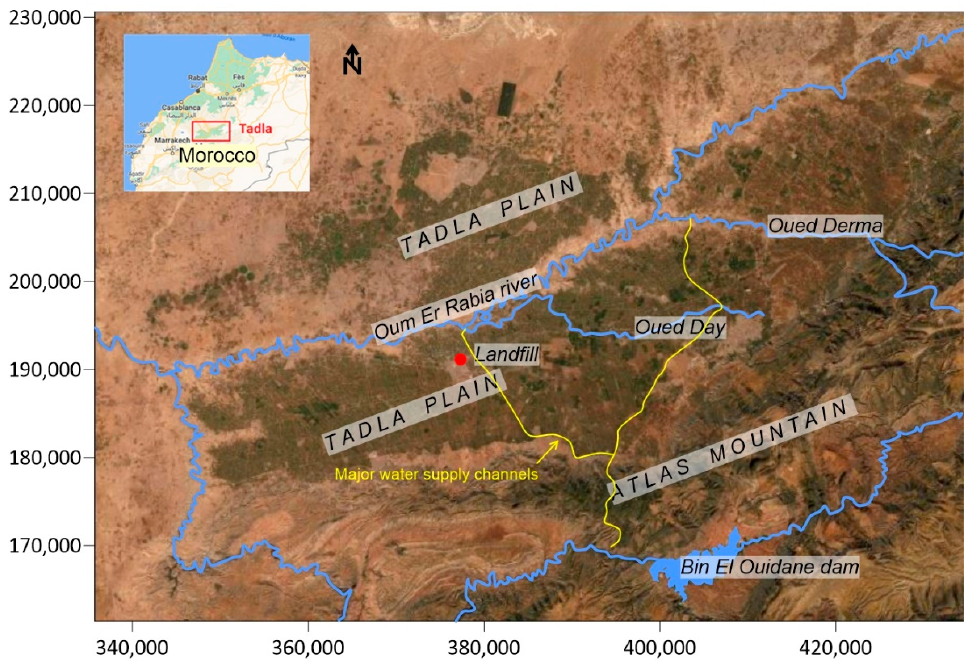
Figure 1. Geographical framework and location of the Souk ‐ Sebt landfill in the Tadla plain. UTM coordinates in metre using Lambert conical conformal projection (Morocco zone 1).